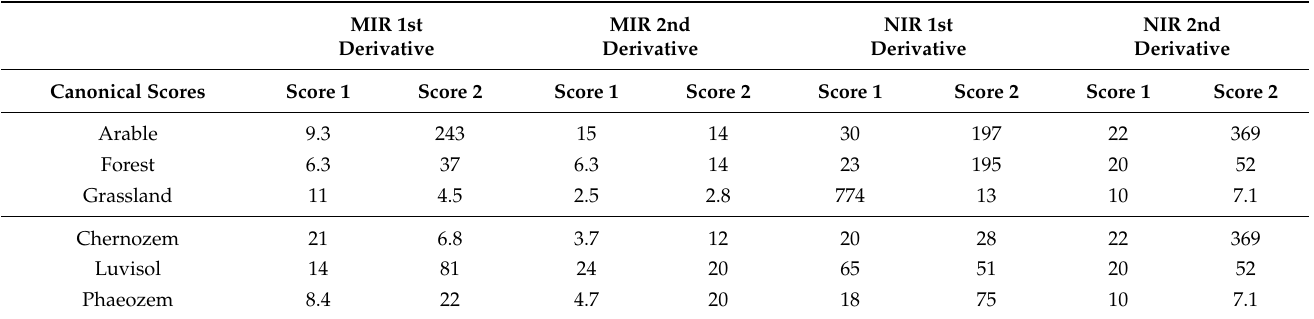
Table 2. Coefficient of variation (CV) for land use and soil groups after CVA analysis, based on Figures 3 and